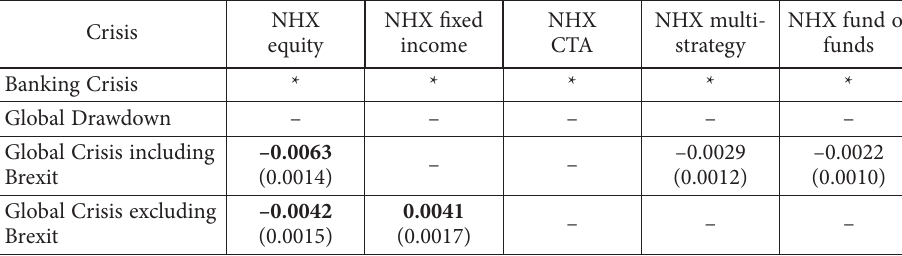
Table 14. NHX strategy index crisis